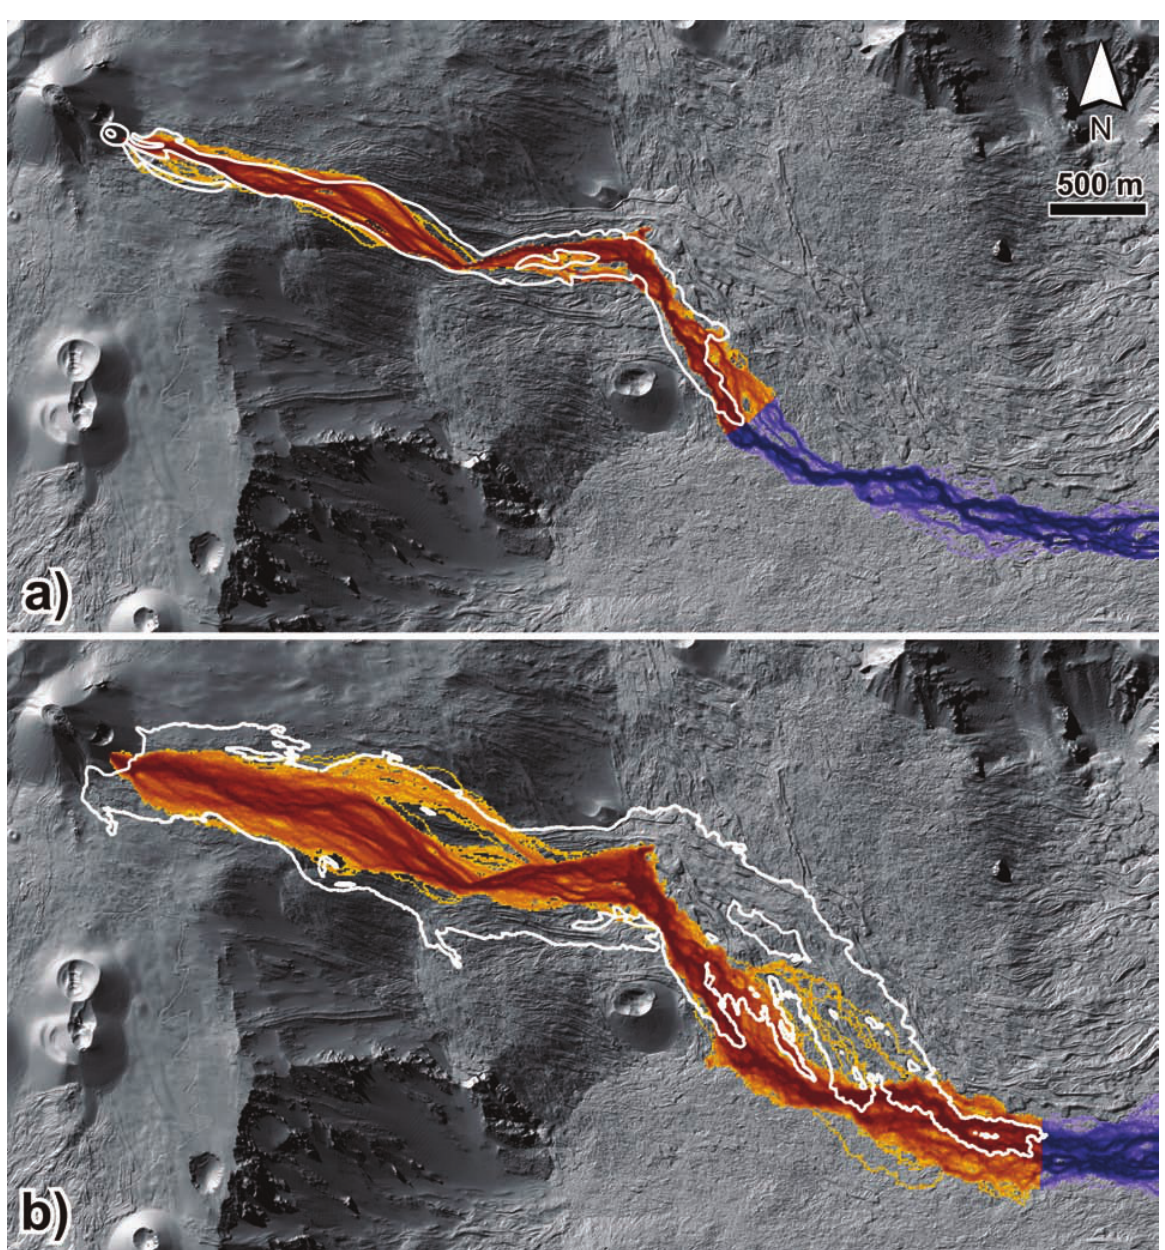
Figure 2. Comparison between real (white lines) and simulated (colored areas) lava-flow paths for the 2006 eastern flow field. Lighter and darker colors, lower and higher frequencies of simulated lava-flow passage, respectively. Red hues, areas located at a distance from the vent lower than the maximum distance attained by the real lava flows. a) DOWNFLOW best-fit simulation (with D h = 1 m, (cid:0)µ = 0.75) for the initial stage (up to July 24) of the 2006 effusive activity on the east flank; b) best-fit (with D h = 3 m, µ = 0.68) for the final eastern 2006 compound lava